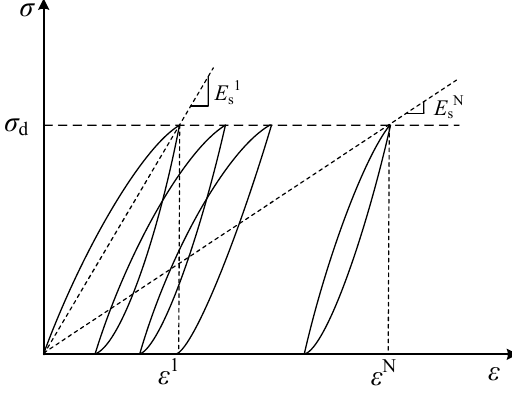
Figure 7. Decay curve of secant elastic modulus in clay.